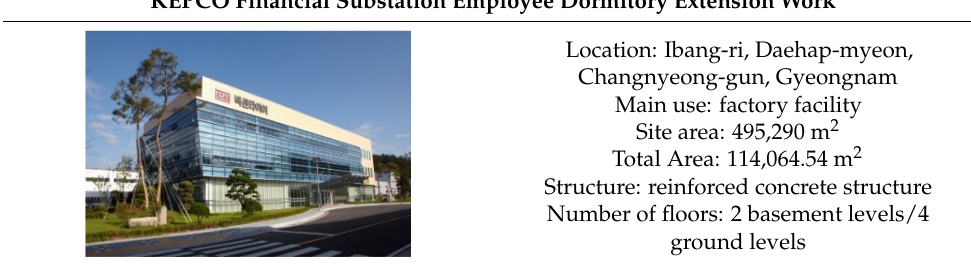
Table 10. Overview of the fourth project to be